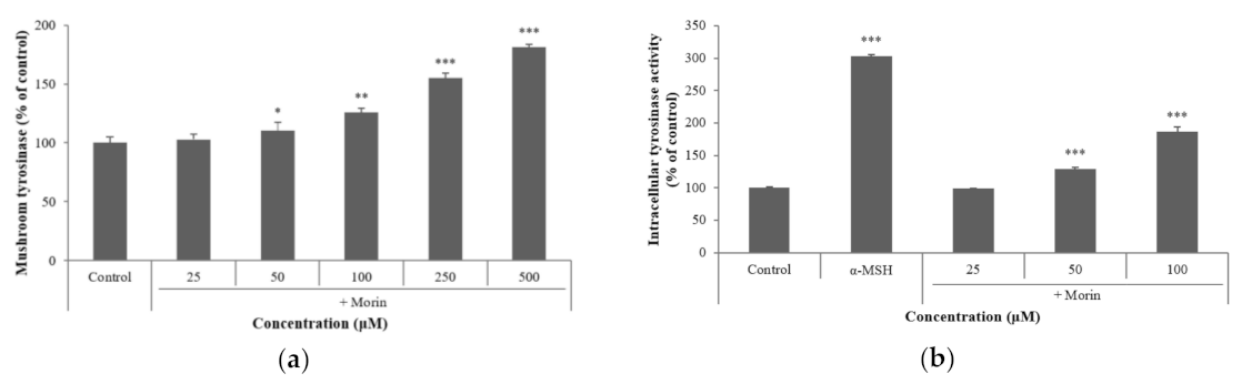
Figure 3. Effect of morin on tyrosinase activity. ( a ) The effects of morin on mushroom tyrosinase activity were determined as described in the Materials and Methods section. ( b ) B16F10 mouse melanoma cells were treated with morin (25, 50, and 100 µ M) for 72 h, and the intracellular tyrosinase activity was determined as described in the Materials and Methods section; α -MSH (100 nM) was used as the positive control. The data are presented as the mean ± SD of at least three independent experiments; * p < 0.05, ** p < 0.01, *** p < 0.001 compared with the control.